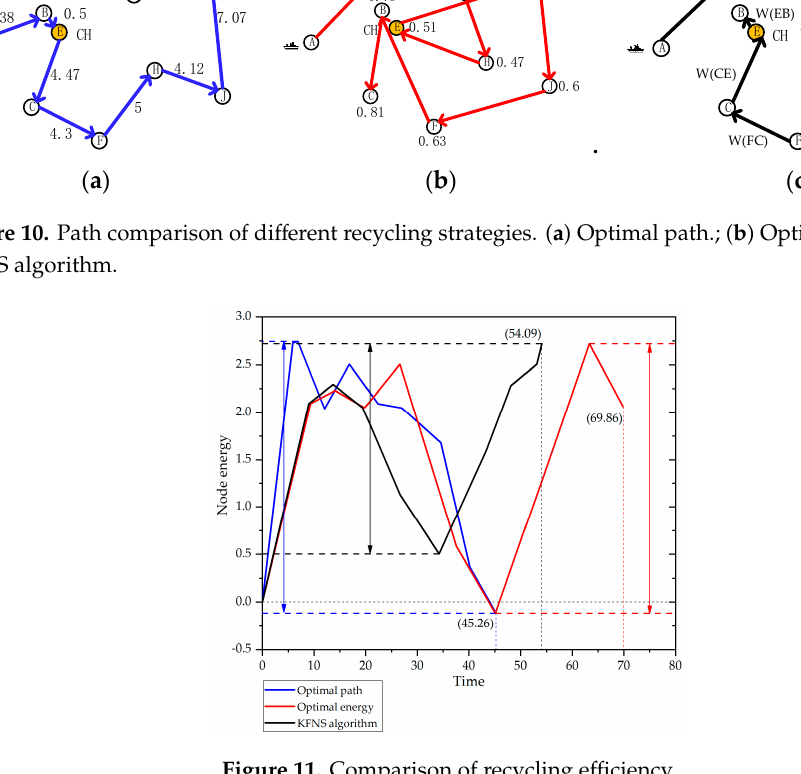
Figure 11. Comparison of recycling efficiency.